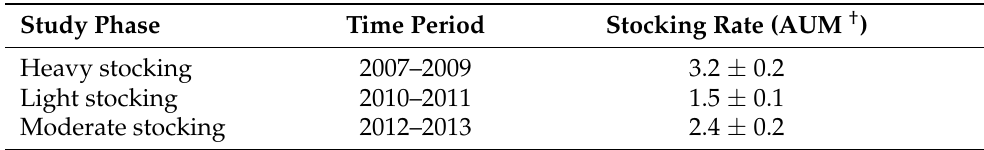
Table 1. Order, duration, and mean ( ± s.d.) stocking rates of the three grazing densities com- pared in eight pastures in Ringgold County, Iowa, USA. † Stocking rate quantified as Animal Unit-Months · ha − 1 , or the combined grazing pressure over time (months) of a number of animal units (455 kg of grazing animal) per hectare of grazed